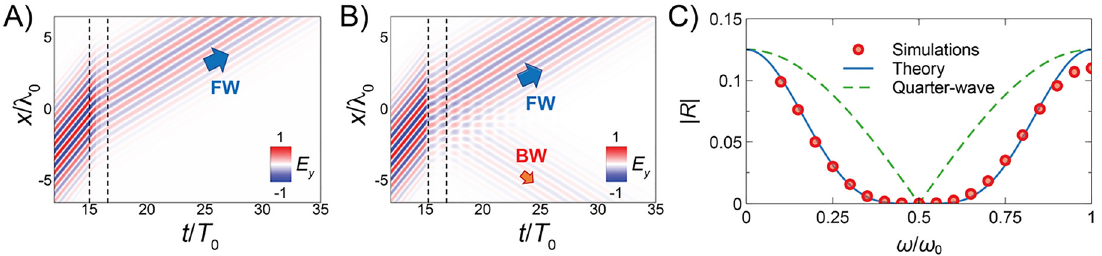
Figure 2: Binomial design: n i = 1, n e = 2, M = 4, n 1 = 1 . 044, n 2 = 1 . 242, n 3 = 1 . 610, n 4 = 1 . 915, δ 1 = 0 . 261 T 0 , δ 2 = 0 . 311 T 0 , δ 3 = 0 . 403 T 0 , and δ = 0 . 479 T 4 0 . (A), (B) Numerically computed space-time maps (normalized electric field) for narrowband modulated Gaussian pulses with center angular frequency ω 0 and 0 . 2 ω 0 , respectively. The vertical dashed lines indicate the initial ( t 0 = 15 T 0 ) and fi nal ( t M = 16 . 453 T 0 ) temporal boundaries. (C) Comparisonbetween numerically computed (red circles) and theoretical (blue-solid curve) BW wave coef fi cient magnitudeas a function of normalized angular frequency (in the fi nal medium). Also shown (green-dashed curve), as a reference, is the response of the quarter-wave design ( M = 1, n 1 = 1 . 414, and δ 1 = 0 . 354 T 0